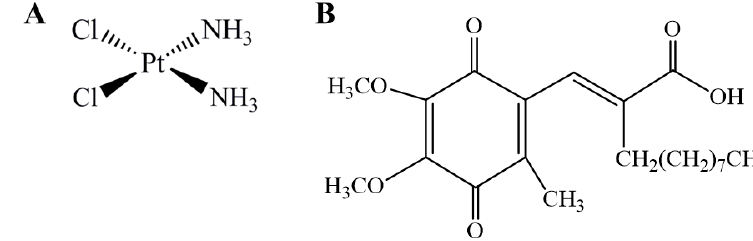
Figure 1. Chemical structure of cisplatin ( A ) and (2E)-2-[(4,5-dimethoxy-2-methyl-3,6-dioxo-1,4- cyclohexadien-1-yl)methylene] undecanoic acid (E3330) ( B cyclohexadien-1-yl)methylene] undecanoic acid (E3330) ( B ).